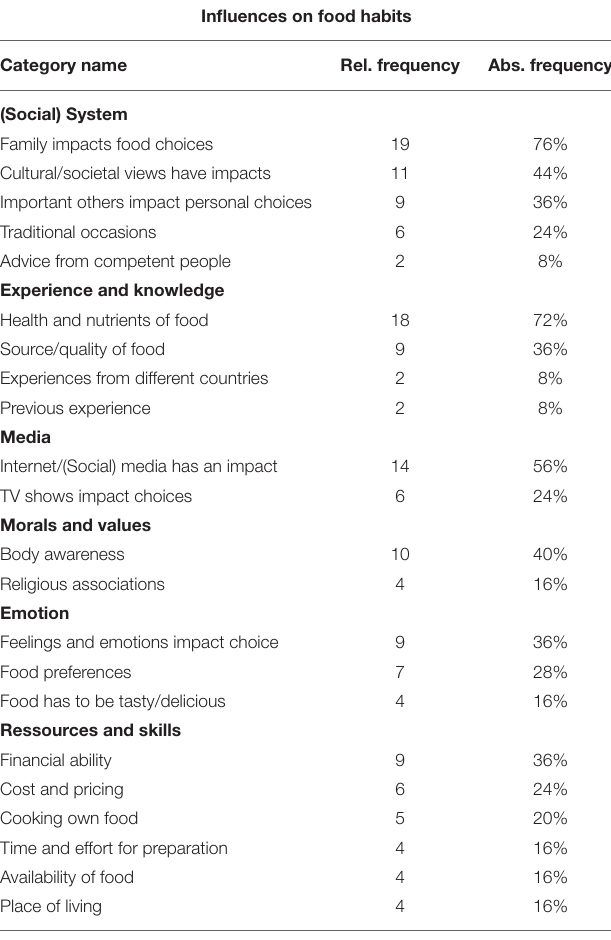
TABLE 2 | Influences on individual food habits found in 25 guideline-based interviews (inductive category system; categories with single occurrence are not mentioned in the category system).